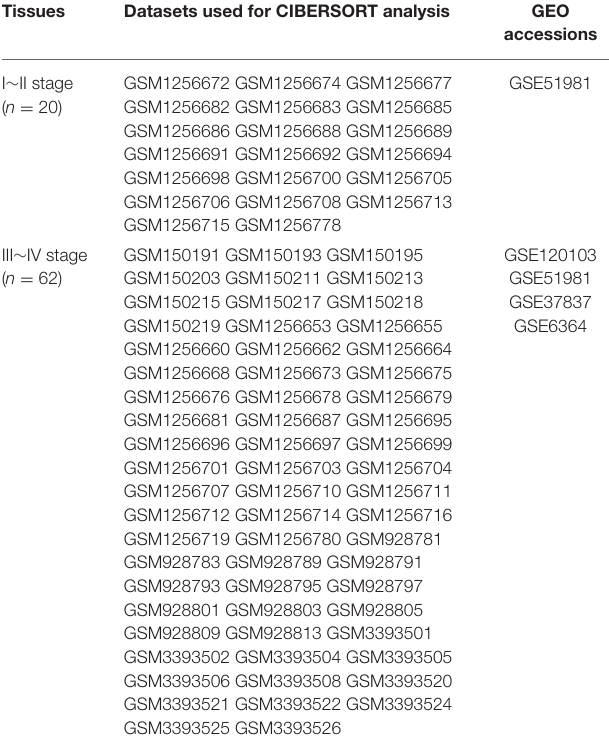
TABLE 1 | Datasets of different stage EMS. Tissues Datasets used for CIBERSORT analysis GEO